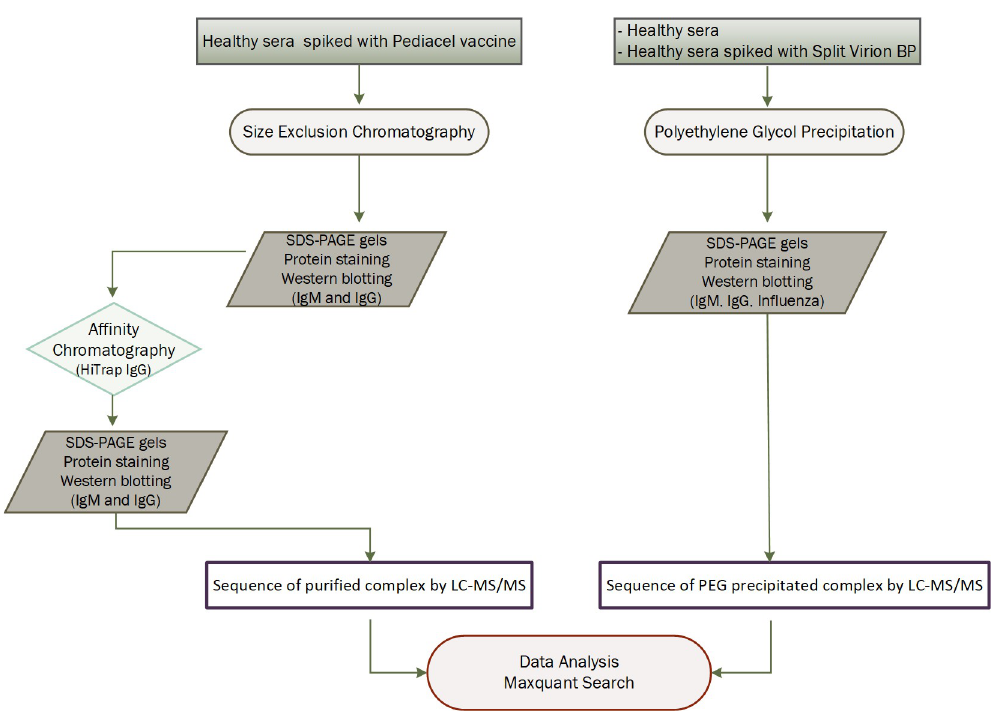
Fig 1. Experimental workflow showing the strategy involved to recover and purify ICs.